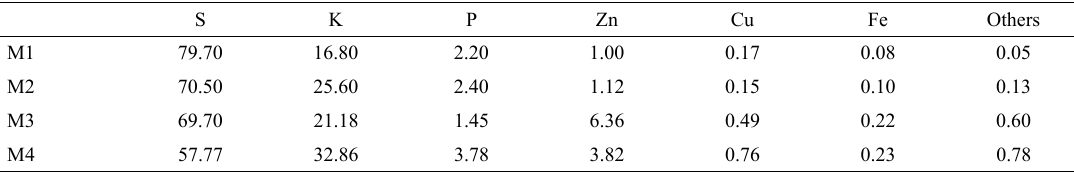
Table 1. Chemical composition of the M1, M2, M3, and M4 membranes.